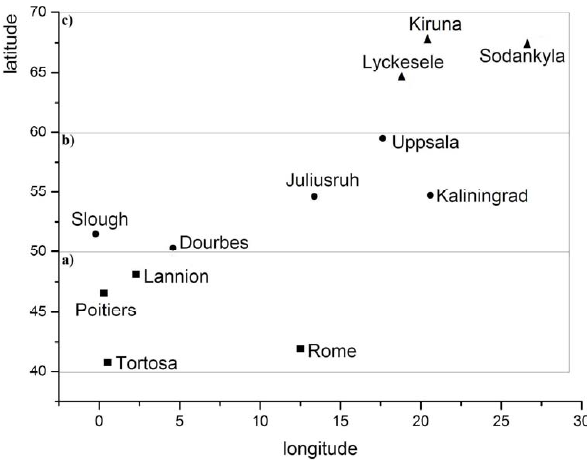
Fig. 1. Geographic area showing the 12 ionospheric observatories for which the short-term forecasting empirical local models were developed. (a) The squares mark the stations situated at middle lati- tudes (40 ◦ N ≤ λ ≤ 50 ◦ N); (b) the circles mark the stations located at middle-high latitudes (50 ◦ N < λ ≤ 60 ◦ N); (c) the triangles mark the stations placed at high latitudes (60 ◦ N < λ ≤ 70 ◦